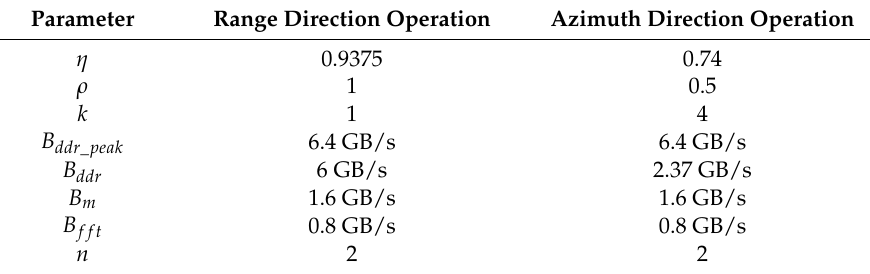
Table 10. Summary of the parameters related to parallel